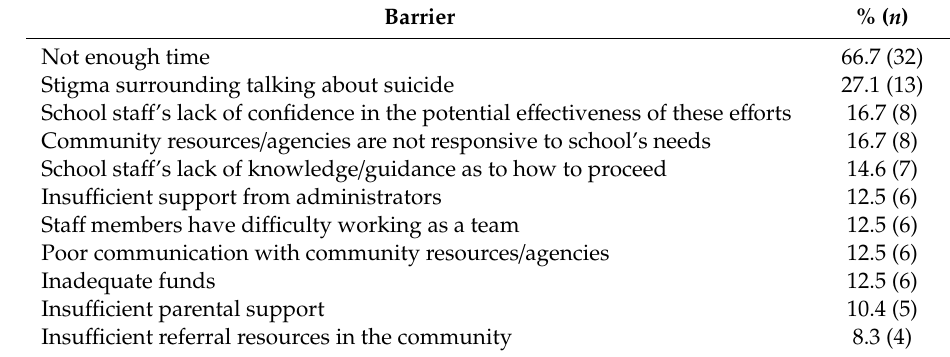
Table5. Barrierstoimplementingschool-basedsuicidepreventionandsuicidesafetye ff